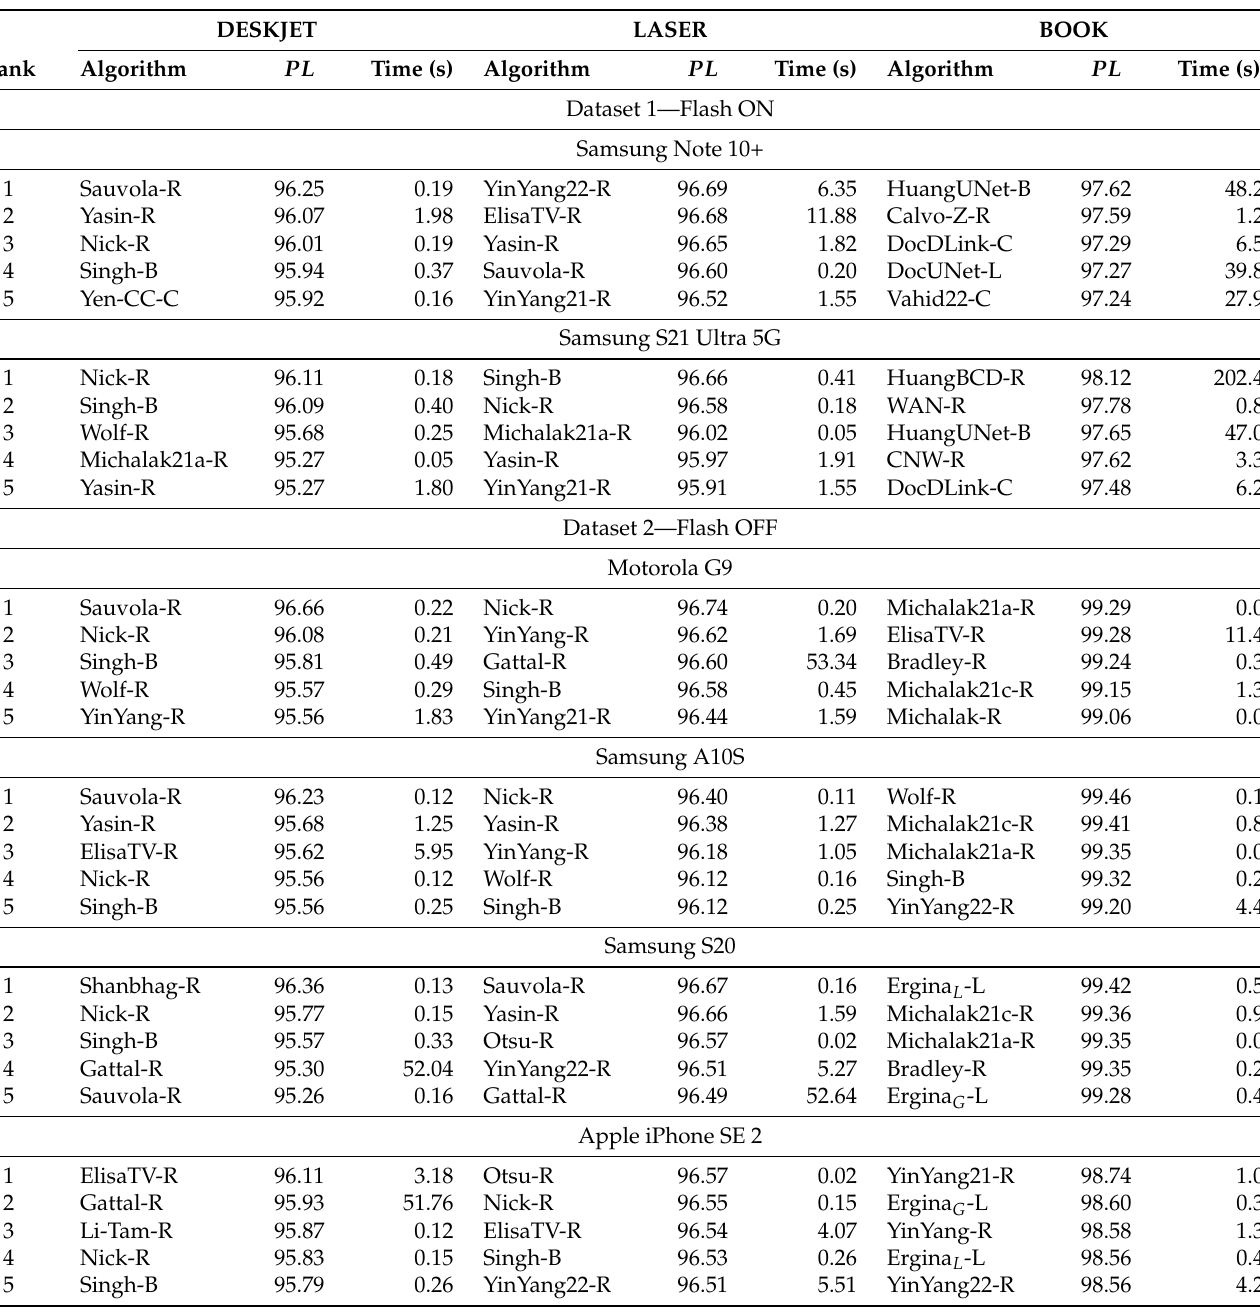
Table 6. Summary of results with PL measure and flash ON state sorted according to the quality-time